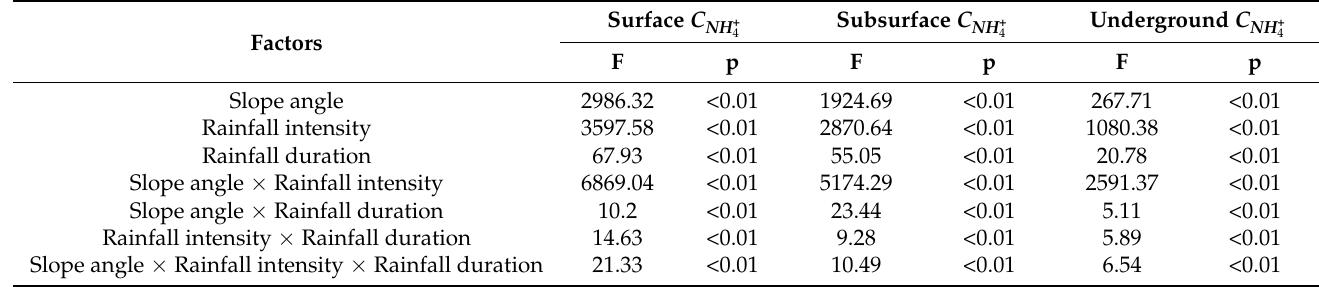
Table 5. Multivariate analysis of variance of runoff ammonium nitrogen concentration with rainfall intensity, slope, and rainfall duration in Karst slope